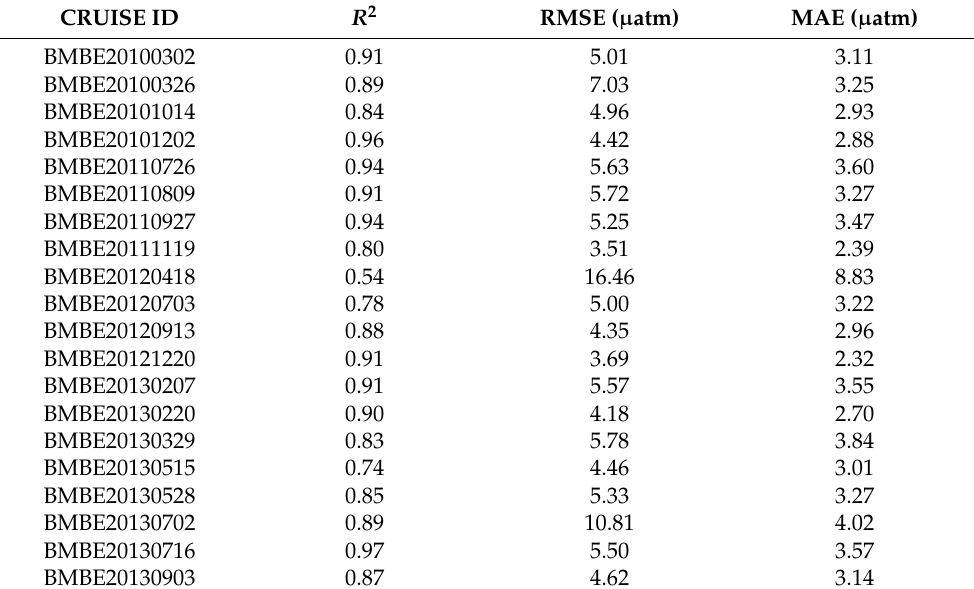
Figure 4. Comparison between field-measured surface pCO 2 and derived pCO 2 in part of cruise. Table 3. The performance of the CatBoost model between predicted pCO 2 and measured pCO 2 for each